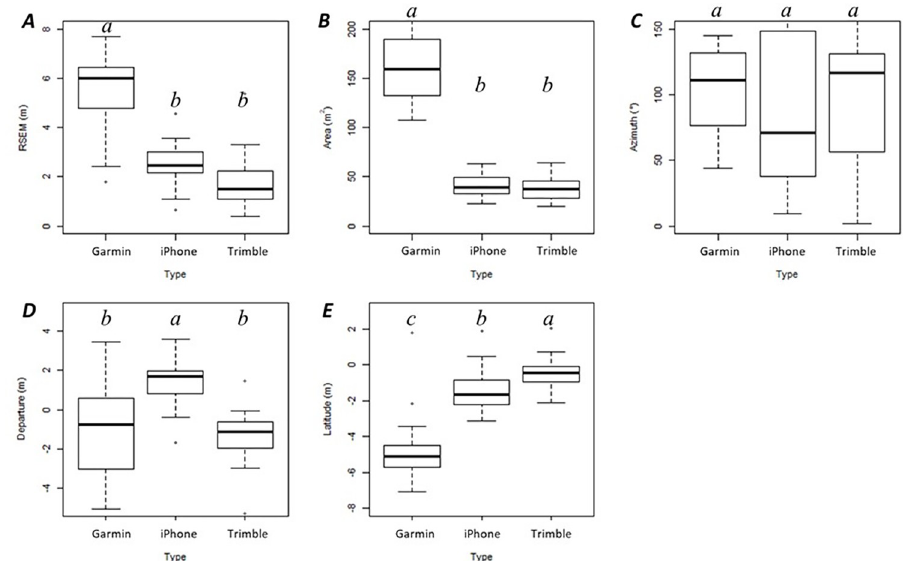
Fig 4. Boxplot for directional distribution observed by GNSS receivers ( A : RSEM (root squared error of the mean, calculated based on the mean center); B : Area of ellipse (m 2 ); C : Rotation (˚); D : Departure (m); E : Latitude (m)). A different letter indicates significant differences ( p <